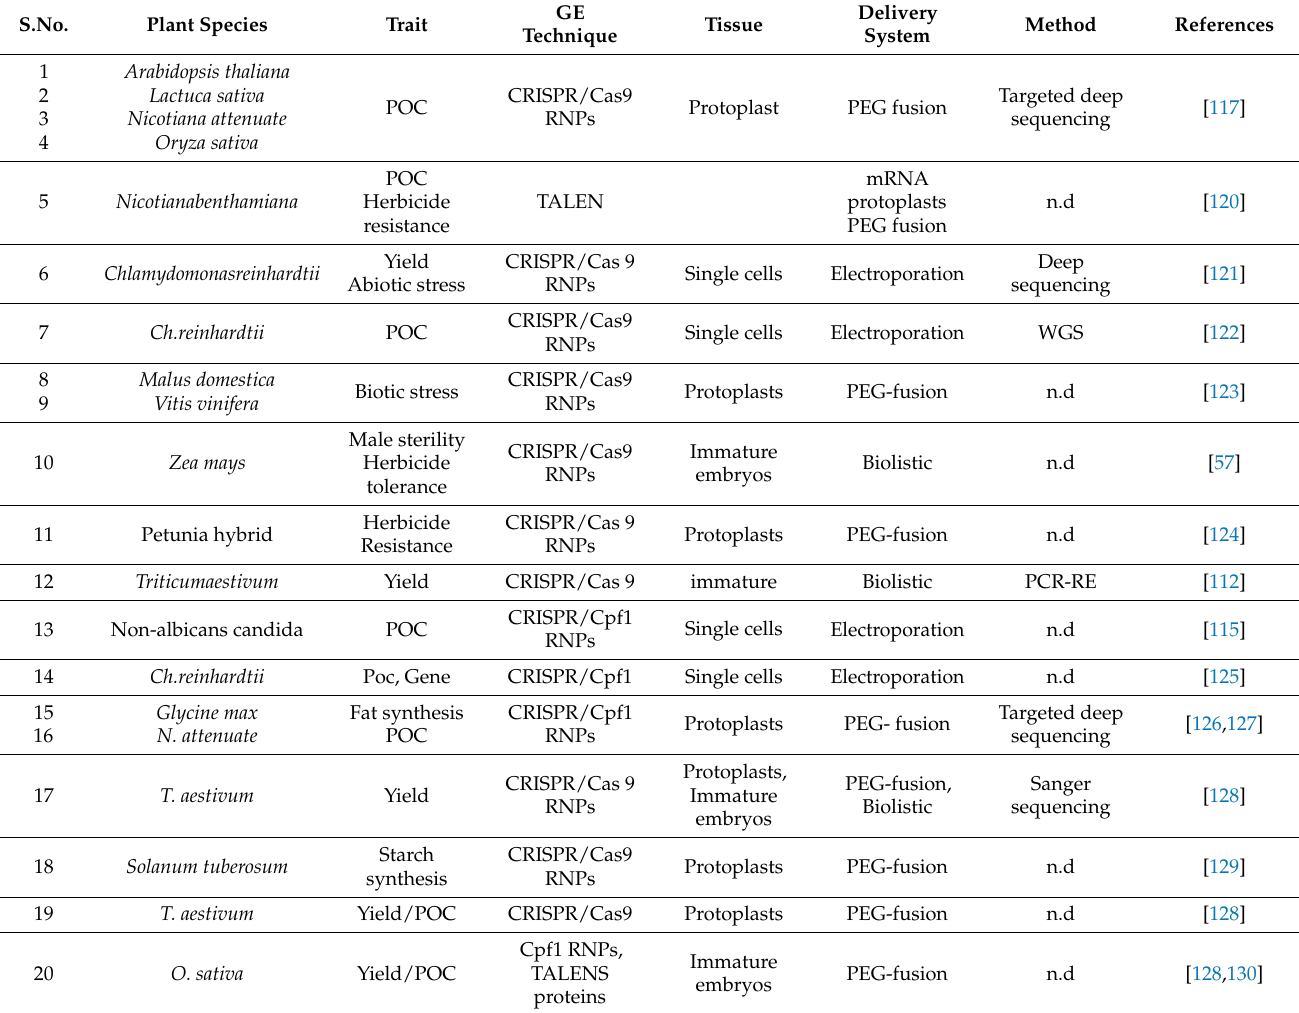
Table 2. DNA-free genome editing approaches used in recent